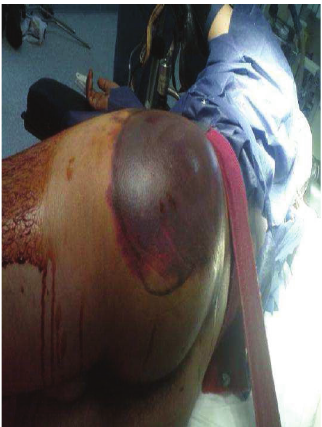
Figure 1: Severe hematoma of the buttock following a gluteal compartment syndrome due to a vascular